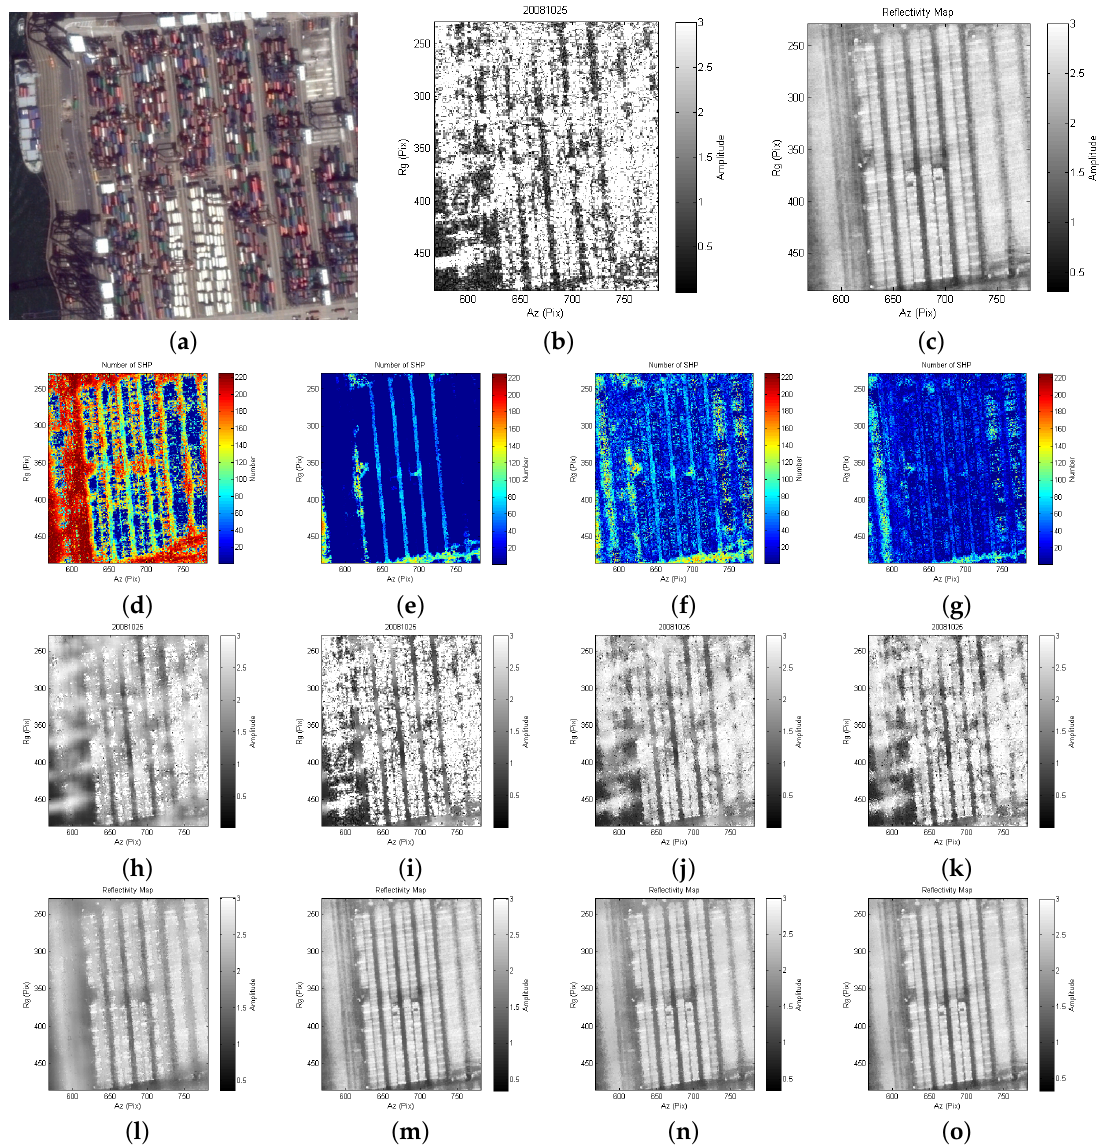
Figure 9. Amplitude denoising of Area 1 based on different approaches and stack sizes. ( a ) an optical image retrieved from Google Earth; ( b ) an unfiltered amplitude map acquired on the 25 October 2008; ( c ) a reflectivity map generated by the original data stack (75 images); ( d – g ) SHP number correspond to AD 10 imgs , AD 75 imgs , TR 10 imgs , and TR 75 imgs , respectively; ( h – k ) denoised amplitude maps correspond to AD 10 imgs , AD 75 imgs , TR 10 imgs , and TR 75 imgs , respectively; and ( l – o ) denoised reflectivity maps correspond to AD 10 imgs , AD 75 imgs , TR 10 imgs , and TR 75 imgs ,